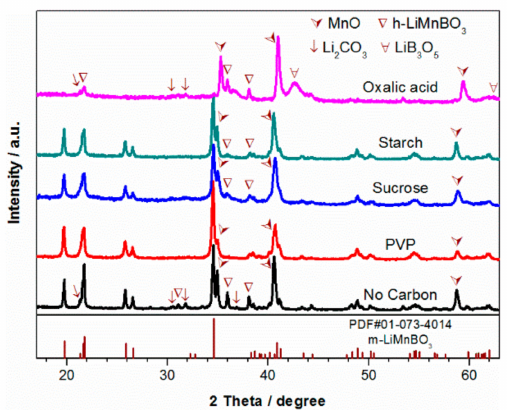
Figure 4. XRD patterns of LiMnBO 3 prepared by ball-milling the raw materials with various carbon additives and without carbon in ethanol.